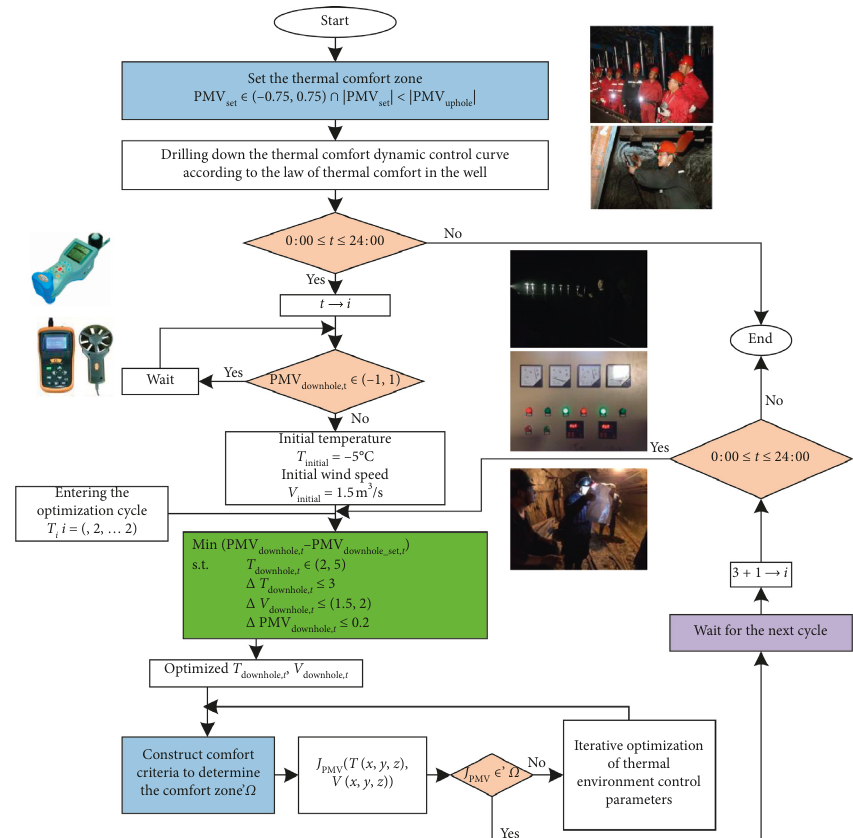
Figure 4: Dynamic flow compensation strategy to obtain the optimal comfort level in mines in high-altitude areas.